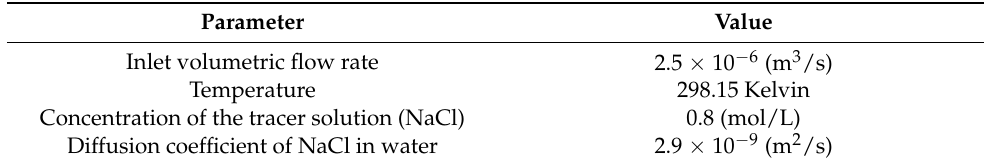
Table 2. Parameters used for CFD